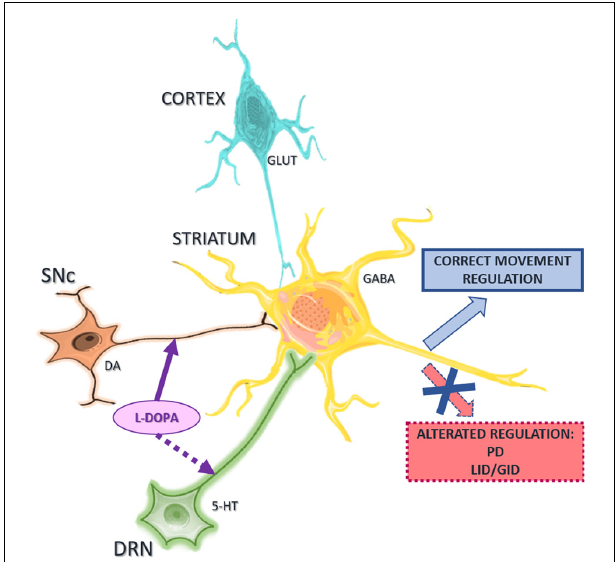
FIGURE 1 | Schematic representation of the major neuronal neurotransmitter systems acting on striatal projection neurons. Interactions between serotonergic, glutamatergic, and dopaminergic systems control the activity of striatal neurons for correct regulation of movement. Abnormal interactions lead to abnormal movement and neurological disorders such as Parkinson’s disease (PD), L-DOPA-induced dyskinesia (LID) or graft-induced dyskinesia (GID). Abbreviations: SNc, substantia nigra pars compacta; DRN, dorsal raphe nucleus; 5-HT, serotonin; DA, dopamine, GLUT, glutamate. The figure was produced using Servier Medical Art